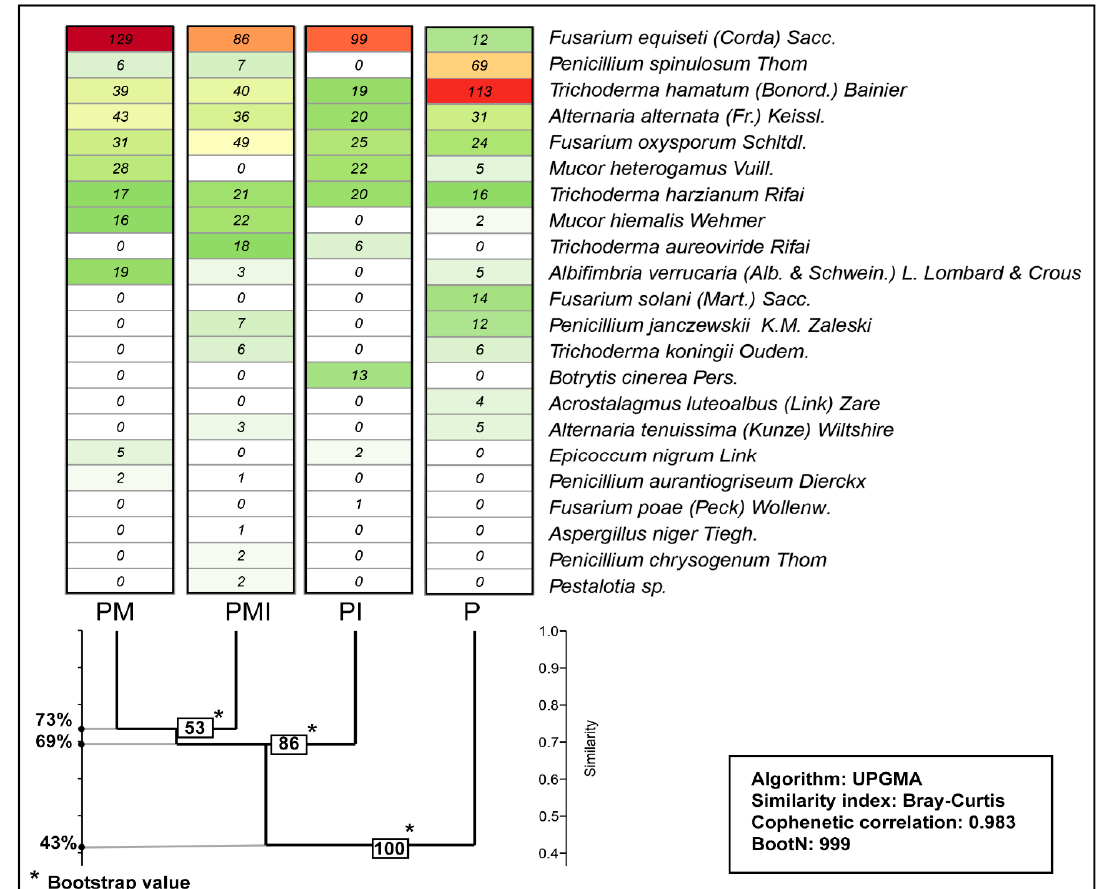
Figure 1. Similarity index of the fungal communities colonizing the rhizosphere of plants as a response to pepper mycorrhization and irrigation in the years 2016–2018. P—plants without mycorrhizal inoculation and irrigation (absolute control), PM—mycorrhized plants, PI—irrigated plants, and PMI—mycorrhized and irrigated plants; red color—higher number of fungi in the community and green color—lower number of fungi in the community. Table 3. Biodiversity indices evaluated by ITS NGS (internal transcribed spacer, next generation sequencing).